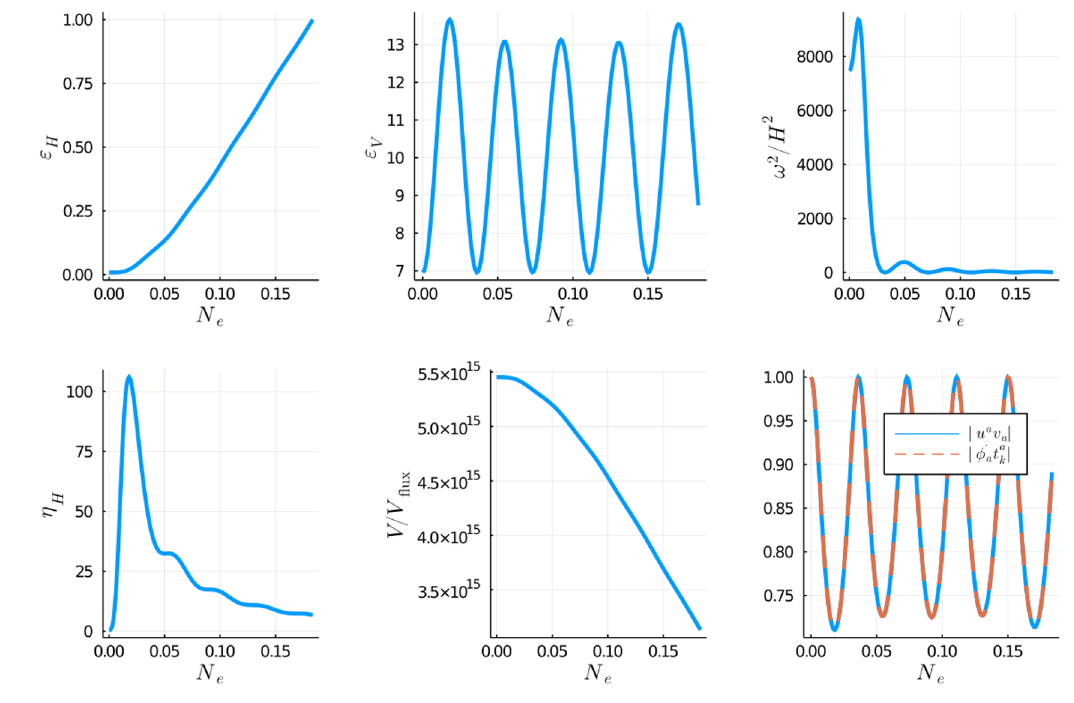
Figure 6 . Several slow-roll parameters and the potential numerically evolved along the trajectory beginning at φ a . Though the trajectory is initially rapid-turn, ω/H rapidly decays and η sharply ? rises, quickly ending inflation after 0 . 183 e-folds. The rapid-turn behavior ends quickly as the Hessian and trajectory misalign within a few hundredths of an